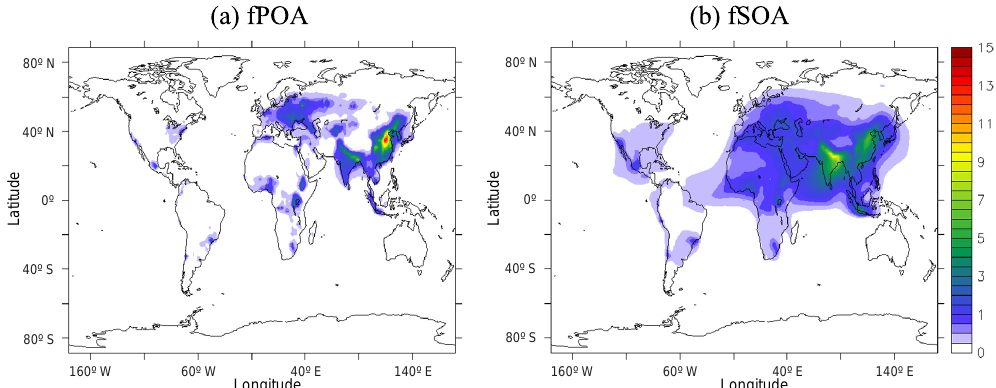
Figure 4. Predicted average surface concentrations (in µgm − 3 ) of (a) POA from fuel combustion sources (fPOA) and (b) SOA from the oxidation of SVOCs and IVOCs from fuel combustion sources (fSOA) during the years 2001–2010.